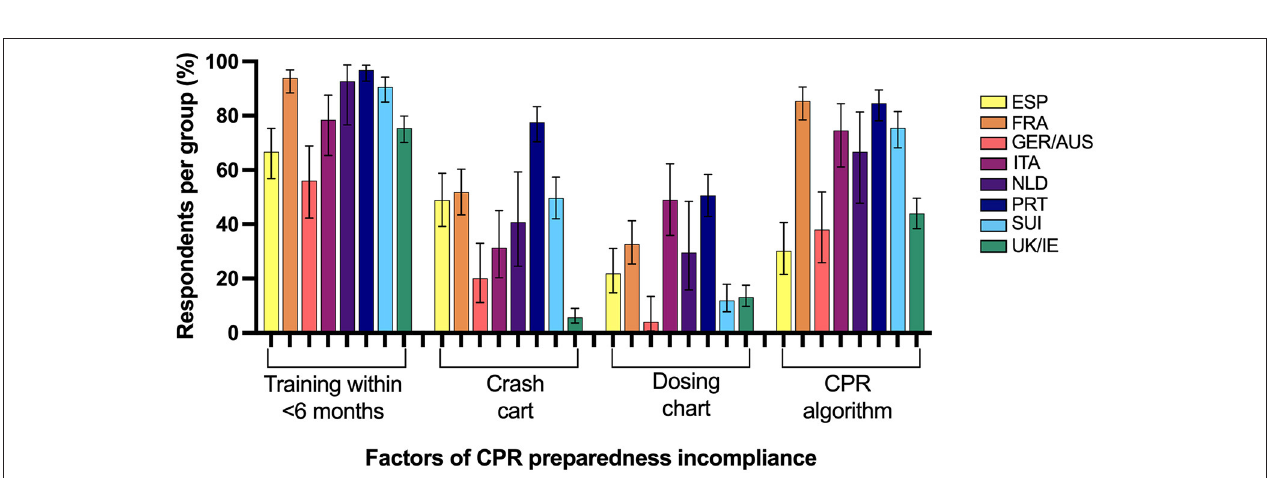
FIGURE 2 | RECOVER guideline compliance and awareness of board-certified specialists or residency trainee respondents ( n = 135) and respondents without residency training ( n = 795) from 8 combined Western European regions. BLS, Basic Life Support; ALS, Advanced Life Support.